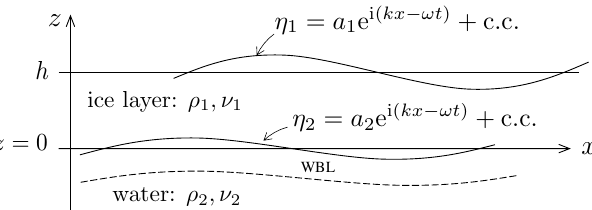
Figure 1. A 2D sketch of a two-layer fluid system, showing the waves propagating on the upper free surface, at the interface, and at the wave boundary layer (WBL) underneath the ice. In η 1 and η 2 , c.c. stands for the complex